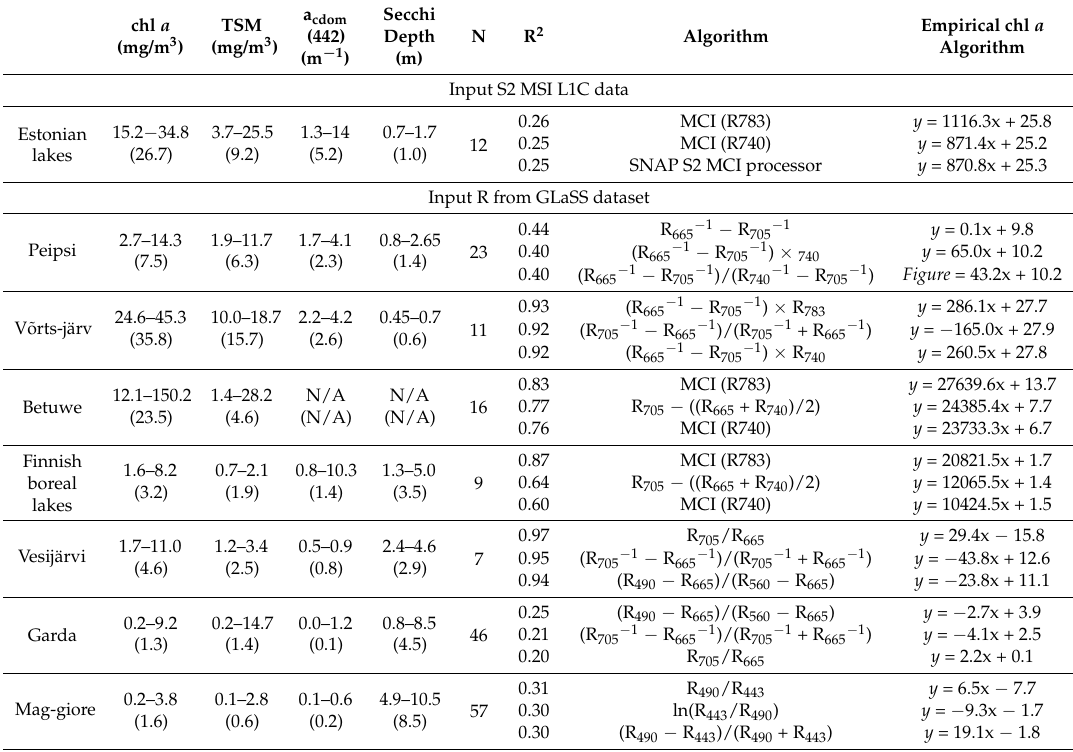
Table 6. Based on the Level-1C (L1C) (MCI based approaches) or Global Lakes Sentinel Services (313256) (GLaSS dataset), three algorithms for every water body were selected based on the highest R 2 . Minimum, maximum, and average concentrations are shown in every lake. The equation for deriving chl a is shown in the last column. Estonian lakes are representing lakes from Table 3, where chl a is over 10 mg/m 3 and empirical chl a algorithm means the empirical algorithm with conversion